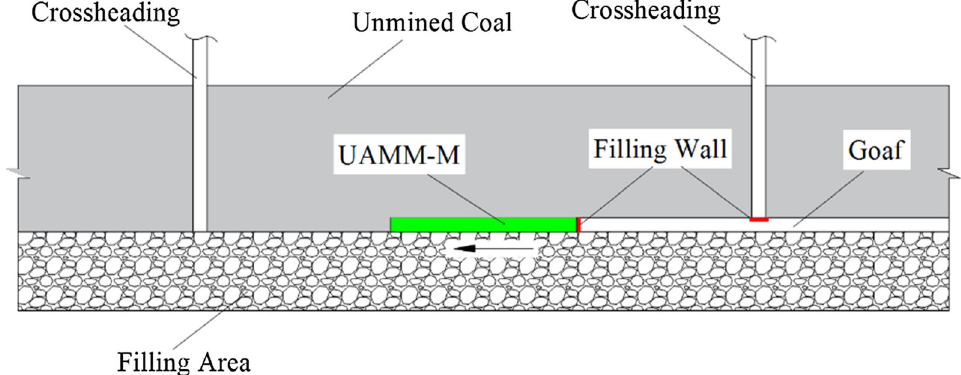
Fig. 6 Top view of the filling wall project for UAMM-based in situ